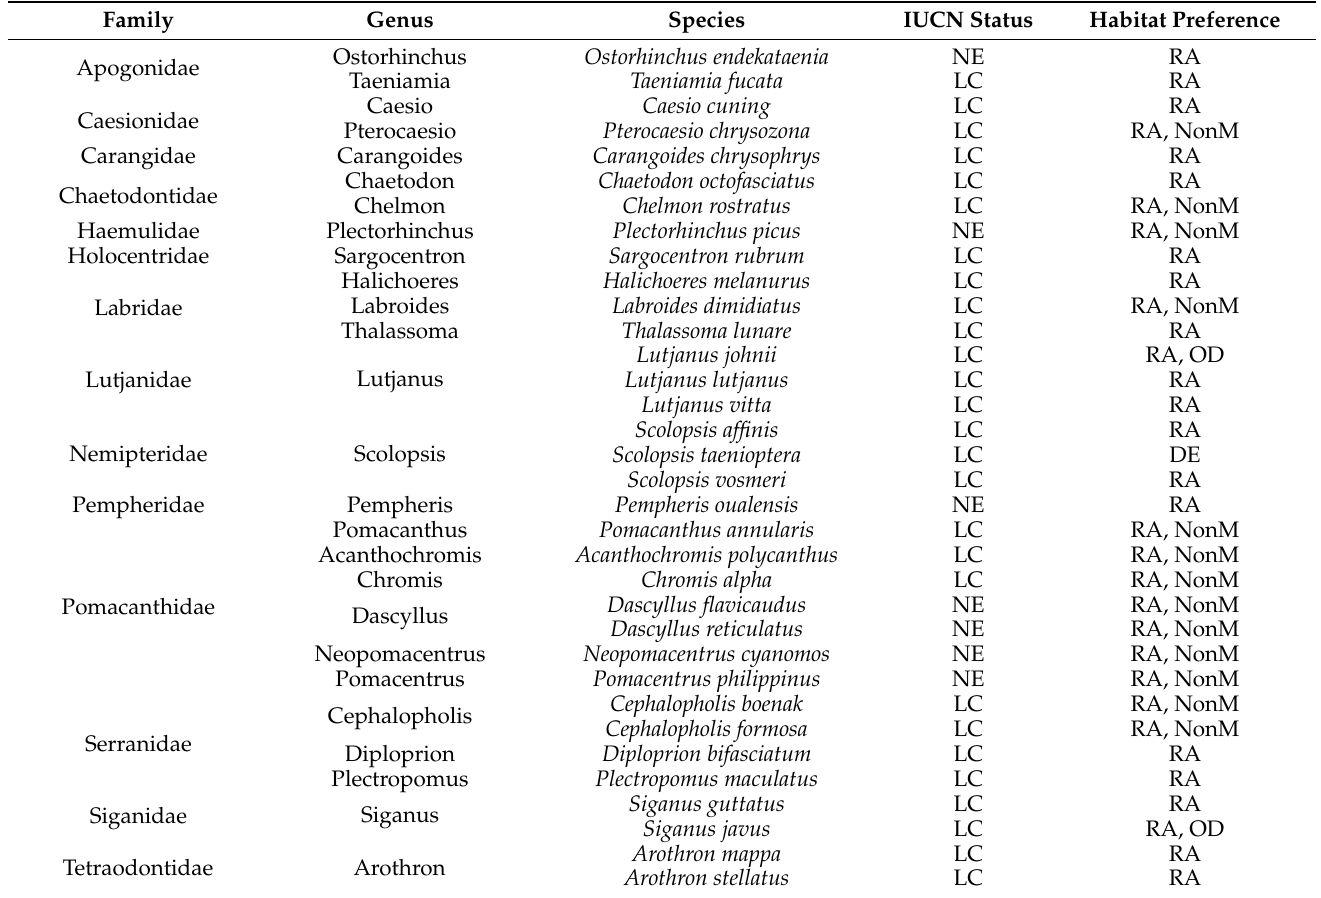
Table 3. List of fish species identified at three BK AR units based on IUCN Red List status (NE = not evaluated; LC = least concern) and habitat preference for each species based on FishBase ® (RA = reef-associated; NonM = non-migratory; OD = oceanodromous; DE = demersal).